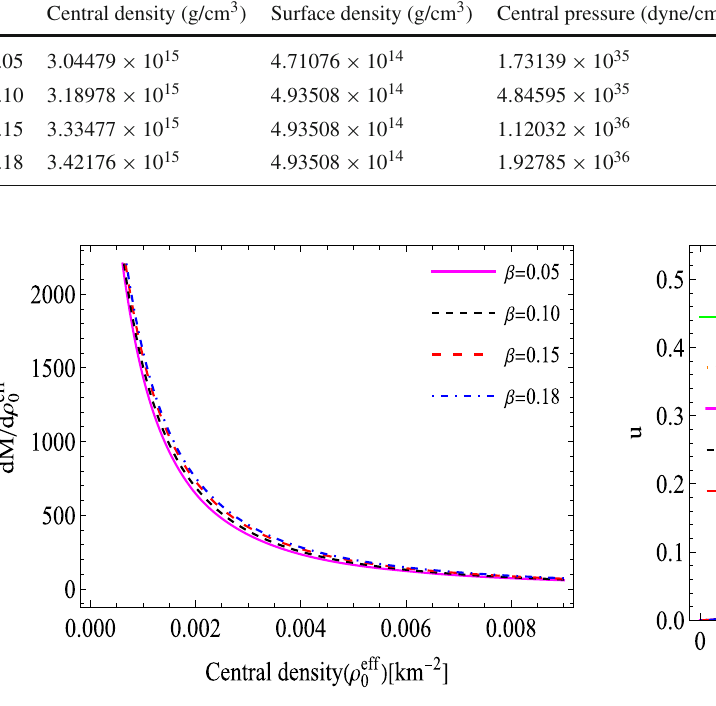
Fig. 7 The above figures show the behavior of dM